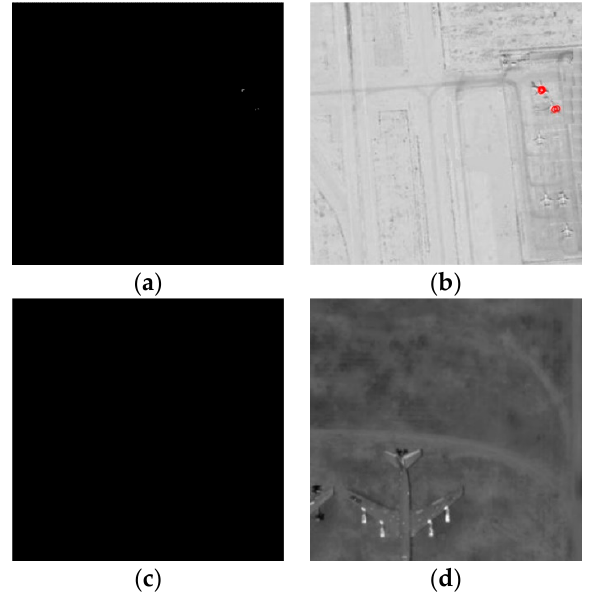
Figure 4. The result graph of weak and small objects; ( a , b ) small object; ( c , d ) weak objects.